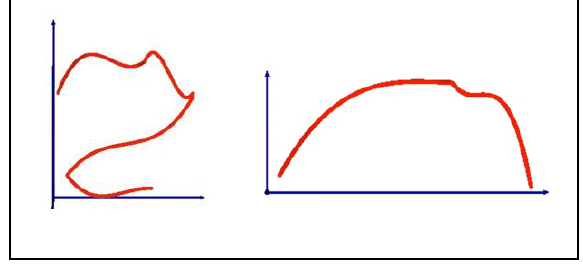
Figure 10. Equations for the definition of two gestures.